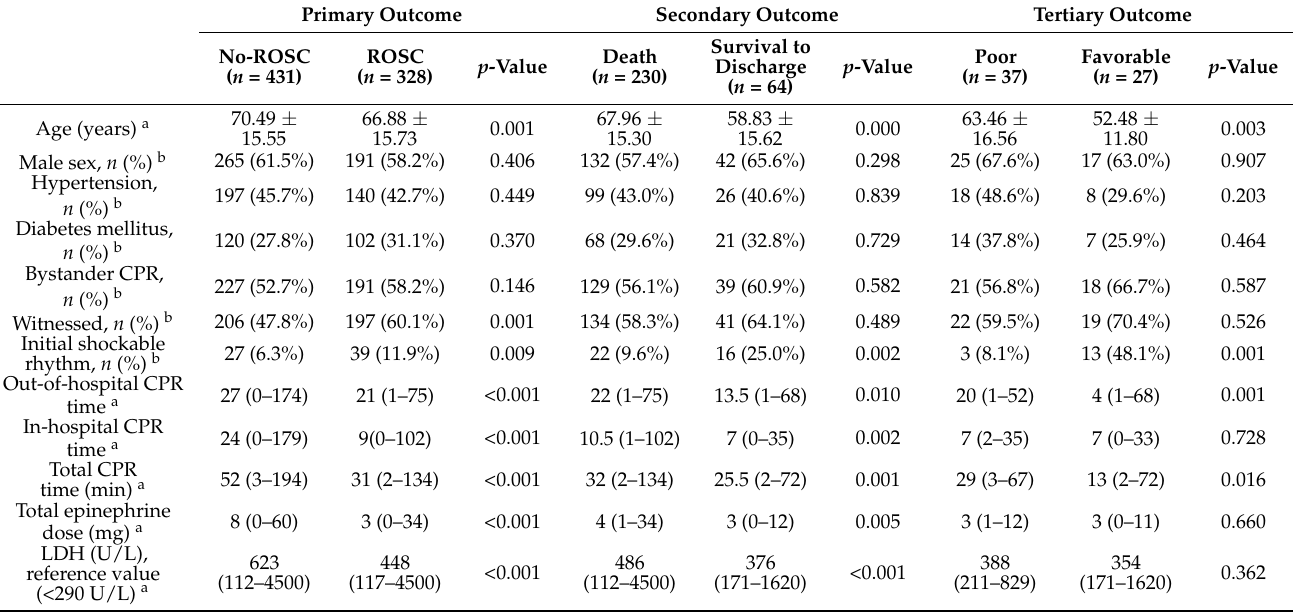
Table 1. Baseline characteristics of patients.